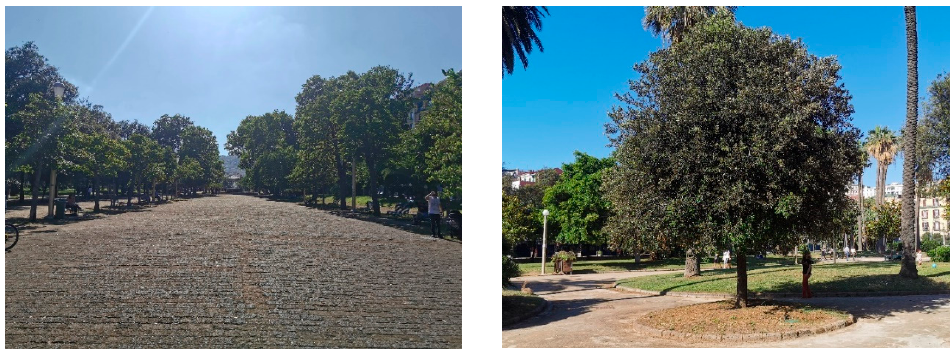
Figure 1. Views of the Villa Comunale of Naples.